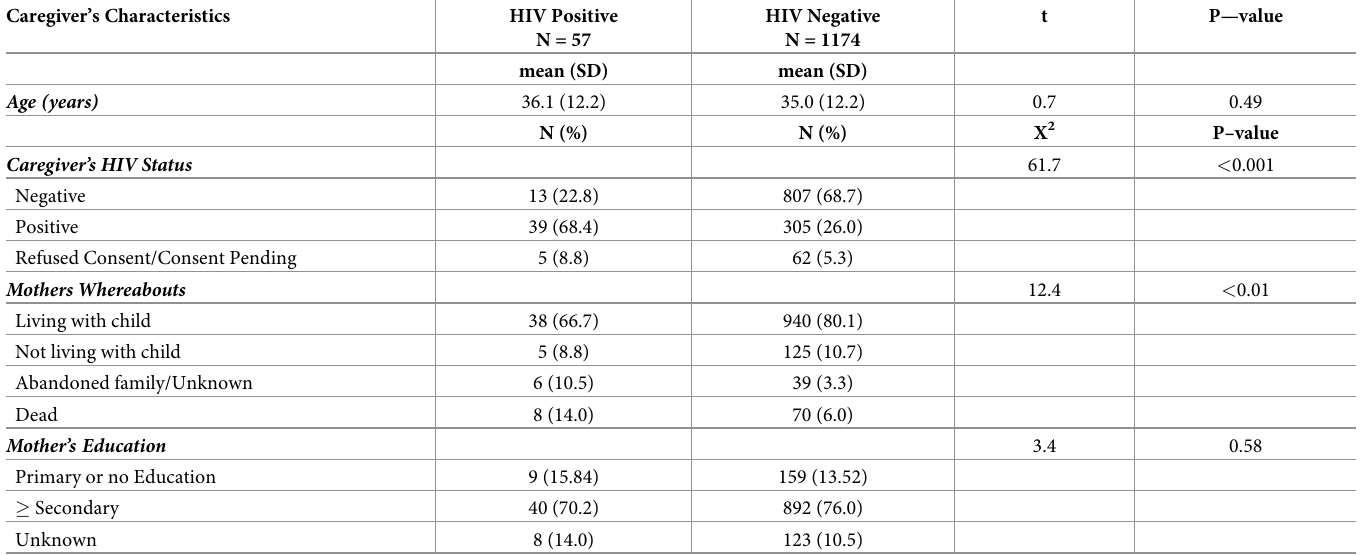
Table 2. Characteristics of children’s caregivers (n = 1231).